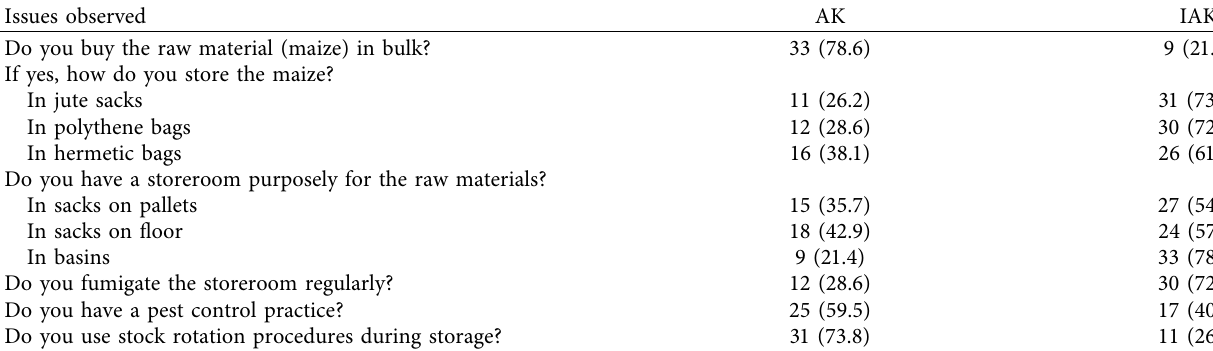
Table 2: Producers’ knowledge in storage handling.